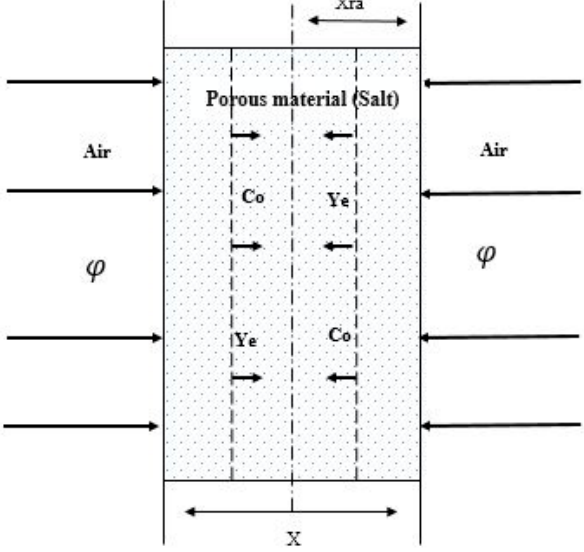
Figure 2. Schematic diagram of the system under consideration.